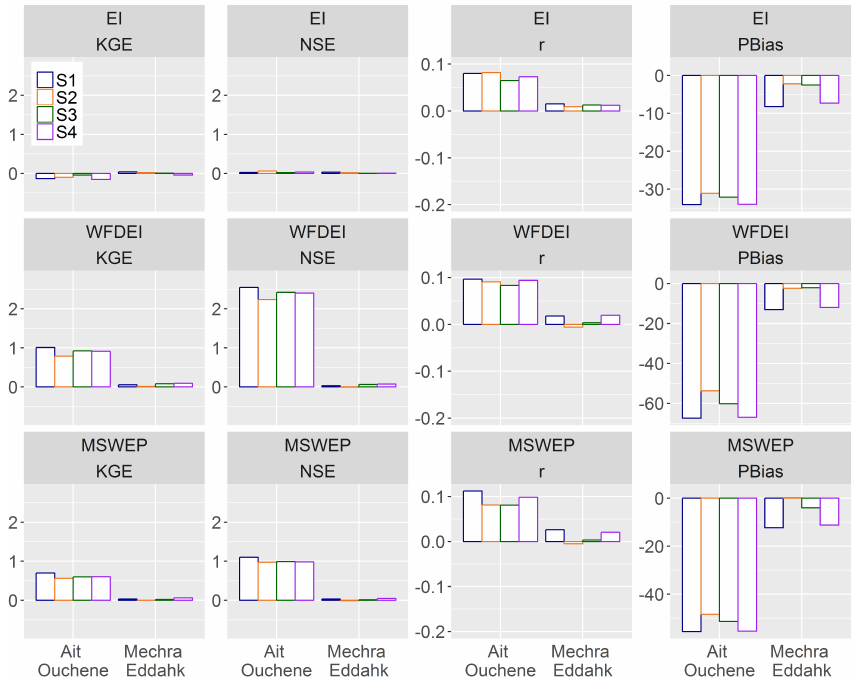
Figure 9. KGE, NSE, r and PBias variations comparing monthly discharge estimates of calibration scenarios S1, S2, S3 and S4 with S0. Rows indicate the three global precipitation products and columns indicate the performance